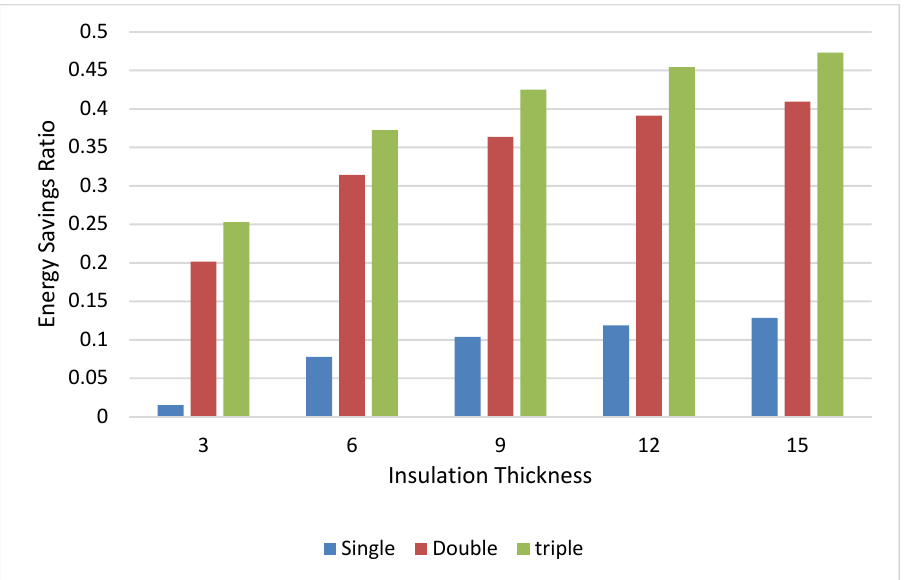
Figure 15. Energy savings ratio versus varying insulation thicknesses and glazing types for the designed zone in Istanbul (40% WWR) .